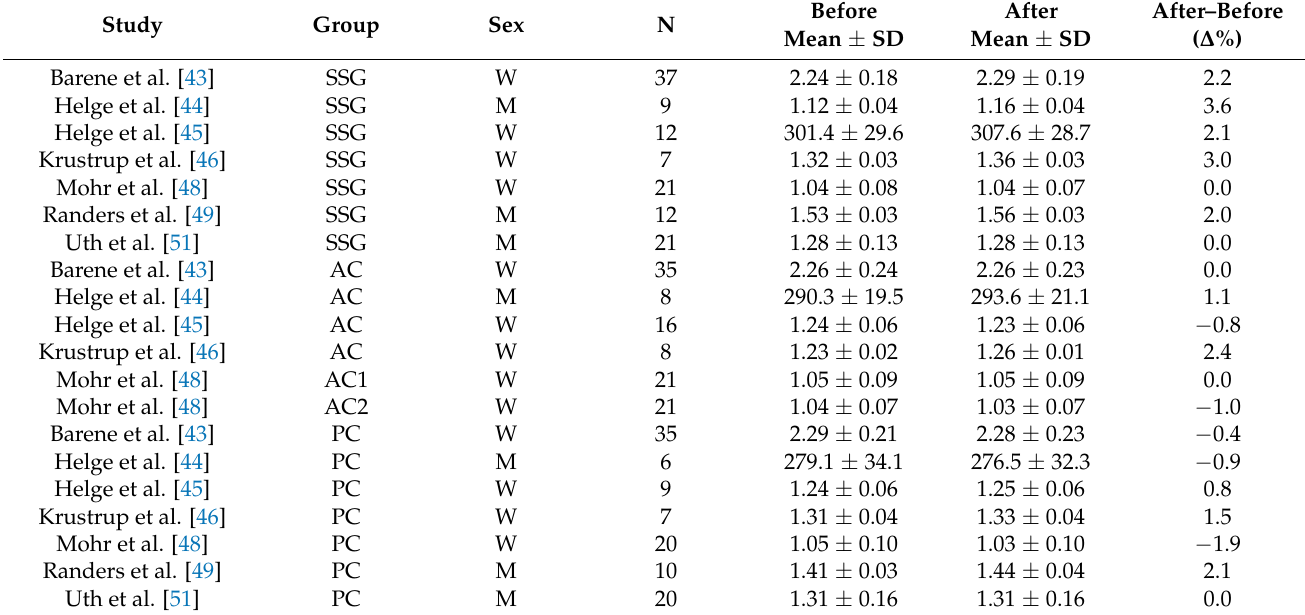
Table 9. Summary of the included studies and results of lower limb BMD before and after the intervention.